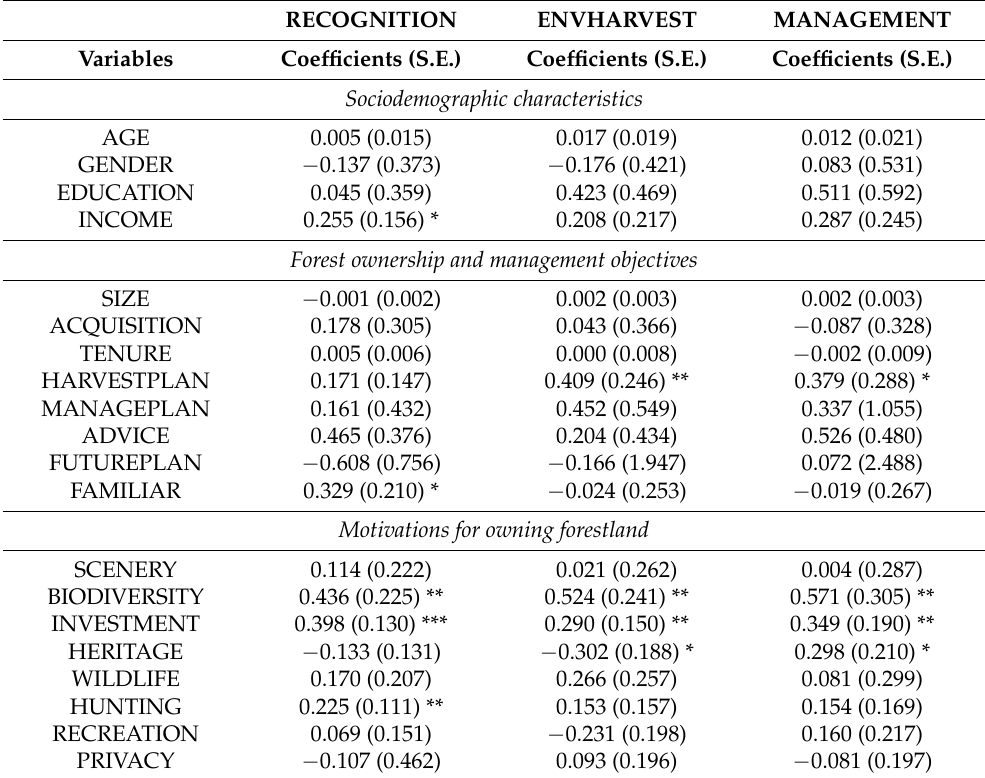
Table 5. Regression estimates of the empirical models for private landowners’ attitudes toward poten- tial benefits of RECOGNITION, ENVHARVEST, and MANAGEMENT related to forest certification (n =